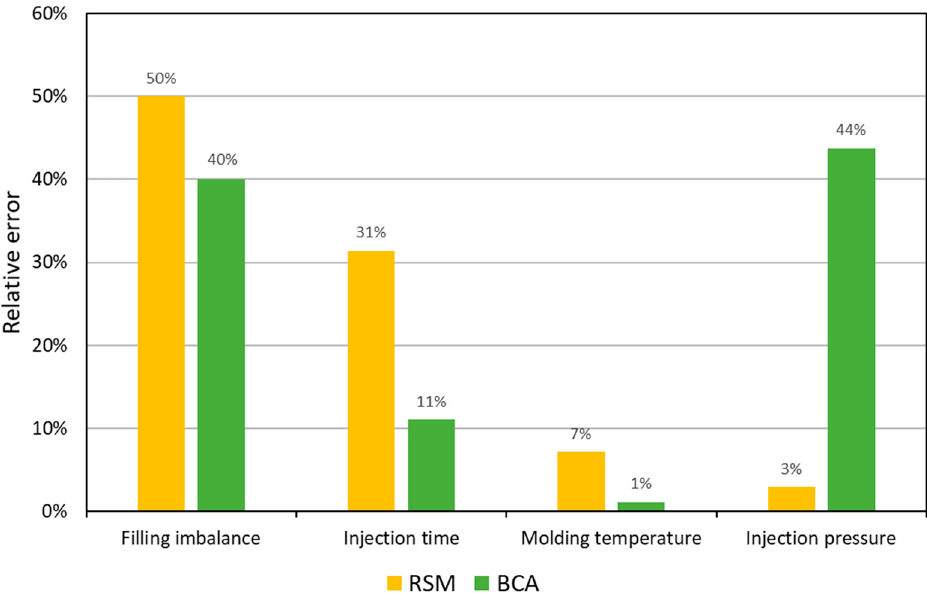
Figure 16. Relative error of experimental validation of simulations performed on the optimized data: filling imbalance I m ( w 1 = 0.5), injection time t inj ( w 4 = 0.2), molding temperature T molding ( w 3 = 0.2), injection pressure P inj ( w 2 = 0.1).